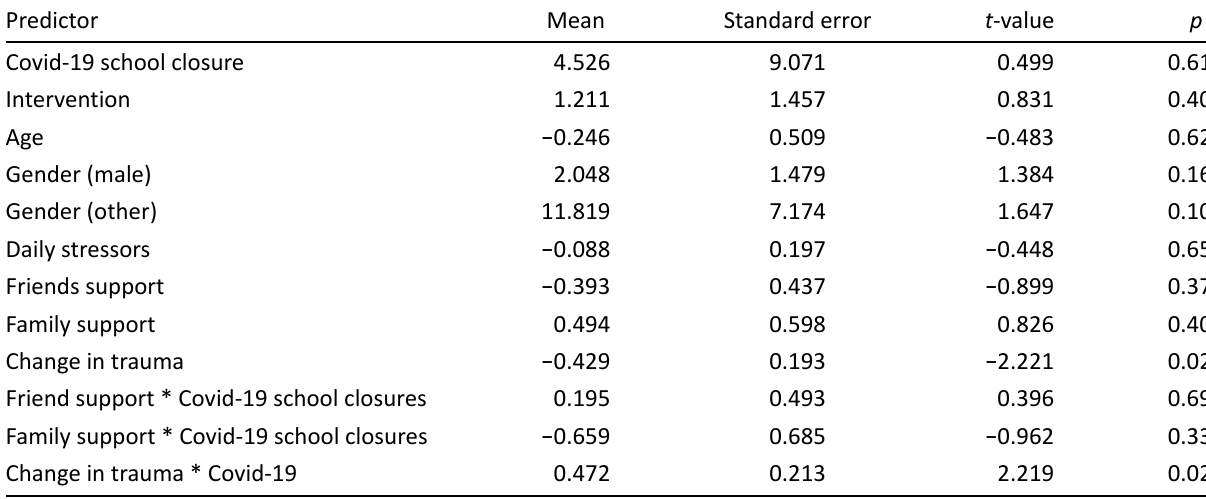
Table 4. Sensitivity analysis: The effect of Covid‐19, post‐traumatic stress symptoms, social support, and socio‐demographic characteristics in the change in school